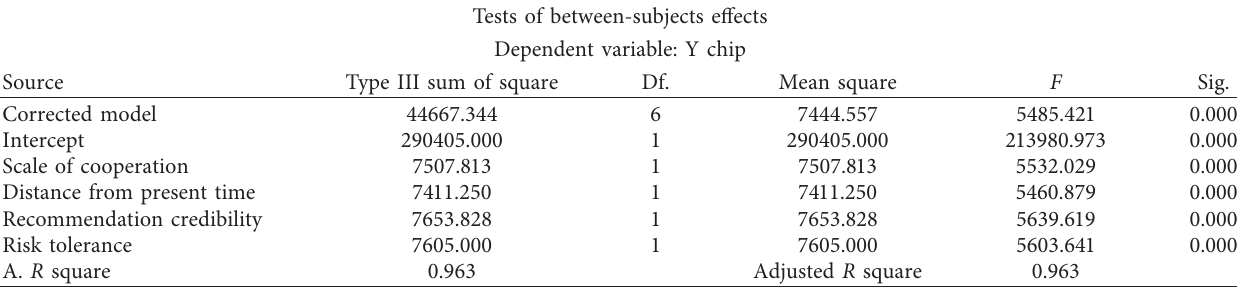
Table 5: Tests of between-subjects effects.